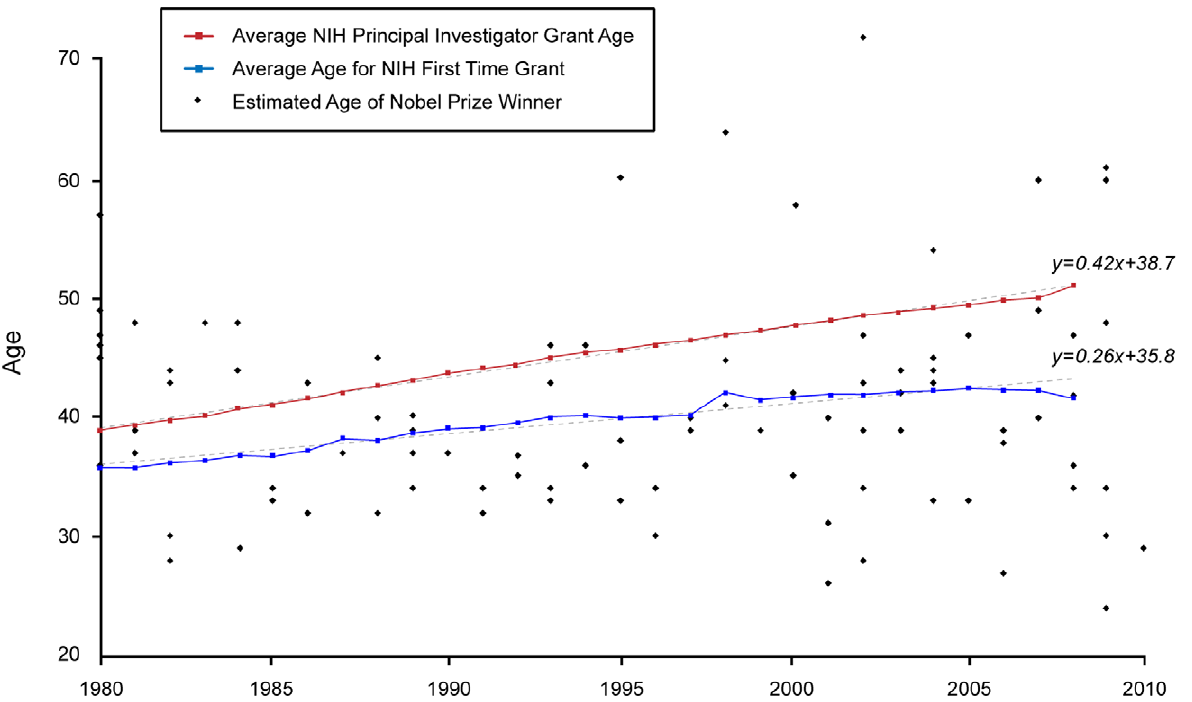
Figure 1. Age Comparison between NIH PIs and First-Time Recipients with Nobel Recipients, 1980- 2010. Since 1980, the average age of an NIH principal investigator (red) and a first-time grant recipient (blue) has steadily increased. The age of principal investigators is rising faster (with a slope of 0.42, p , .001) than first-time grant recipients (with a slope of 0.26, p , .001). Of the 96 Nobel laureates studied, 55 (57%) published their discoveries at an age under the average age for a first-time NIH grant (blue), and 75 (78%) published before the average age for a NIH grant (red). Ordinary least squares regression of the average age of Nobel prize winners on year of award indicated that there was no statistically significant increase in the age over time (p=0.42). This suggested that investigators are publishing Nobel-worthy research at a younger age than a first-time NIH grantee or the average principal investigator.